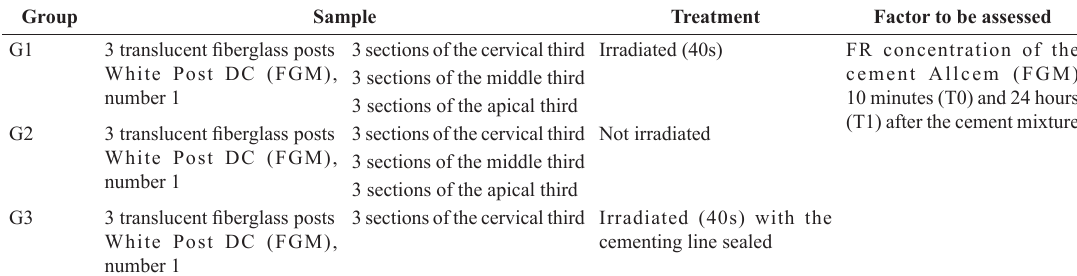
Table 1. Experimental groups and material evaluated.